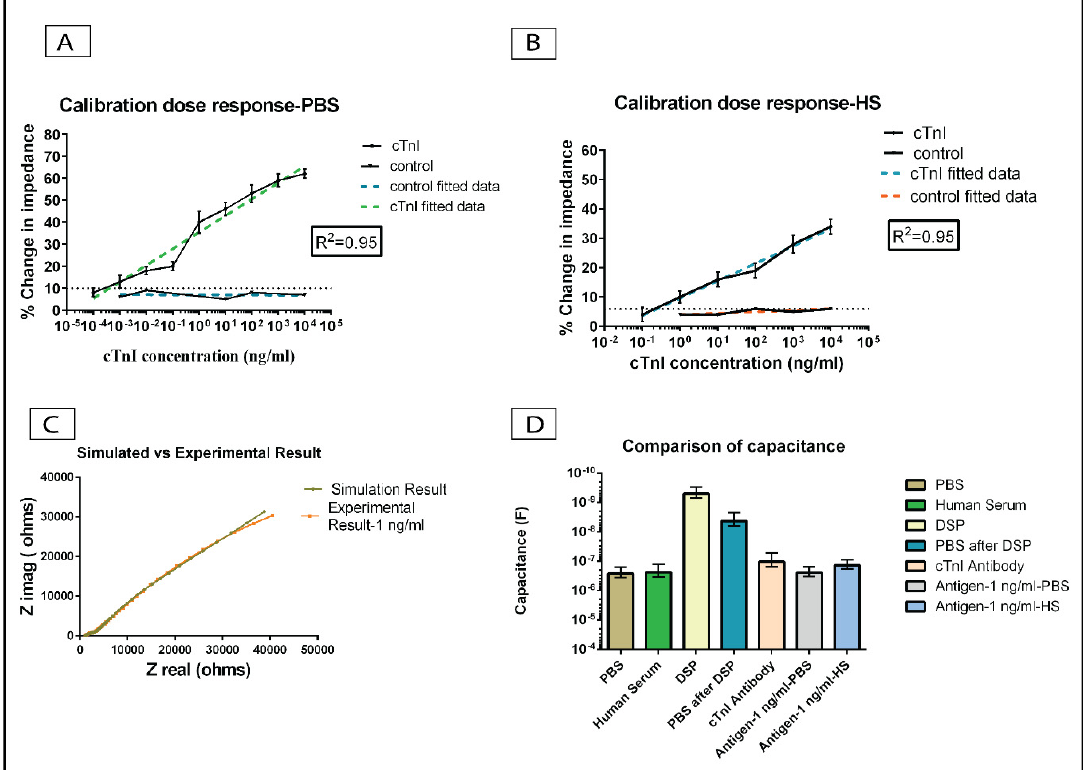
Figure 5. Calibration dose response analysis on Mo sensor. ( A ) Calibration dose response analysis in PBS medium. The dotted line indicates the noise threshold. The limit of detection (LoD) for the sensor in the PBS medium is 10 pg/mL; ( B ) Calibration dose response analysis in HS medium. The LoD for the sensor in HS medium is 1 ng/mL. Error bars represent the standard error of mean from n = 3 replicates; ( C ) Comparison of experimental vs. simulated result for 1 ng/mL of cTnI antigen; ( D ) Comparison of capacitance for various assay steps on Mo biosensor.